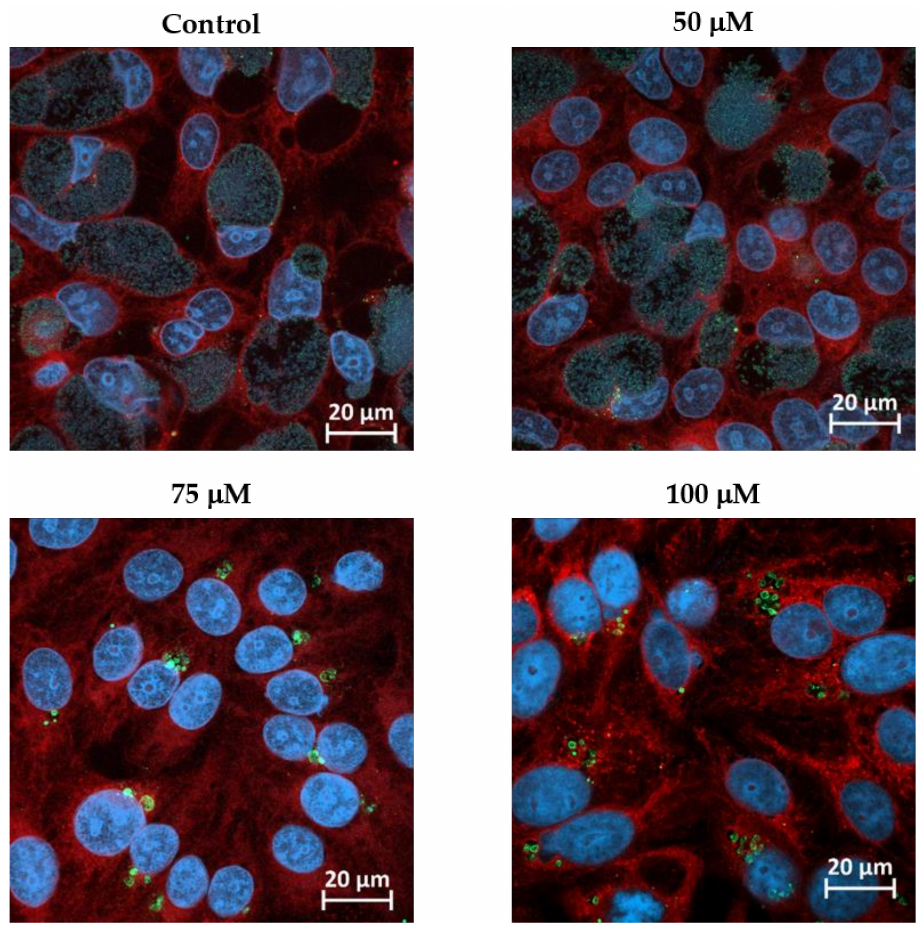
Figure 1. Formation of W. chondrophila aberrant bodies in presence of di ff erent concentrations of BPDL. HEp-2cellswereinfectedwith W.chondrophila andtreatedwith50, 75or100 µ MBPDL2hpi. Infectedcells were fixed 24 hpi, labelled with Concanavalin A (red), DAPI (blue) and anti- W. chondrophila antibodies (green) and observed by confocal microscopy. Images of HEp-2 cells infected with W. chondrophila and treated with BPDL at di ff erent times pi are shown in Figure